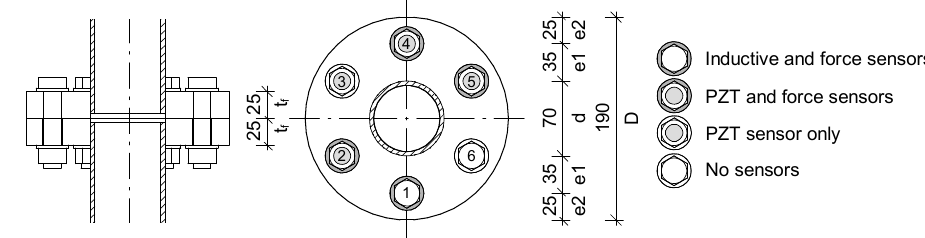
Figure 4. A scheme of the flange connection (P1/P2), screw numbers, and sensor locations (all dimensions are given in mm; washer-type sensors are not